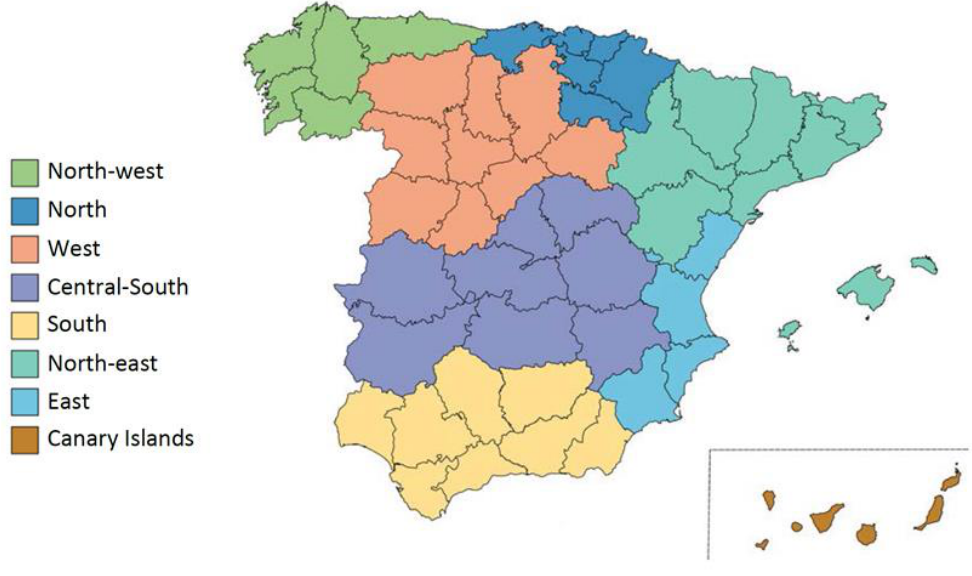
Figure 1. Geographical distribution of Spain in eight areas according to the Ministry of Agriculture, Fisheries, and Food (MAPA).